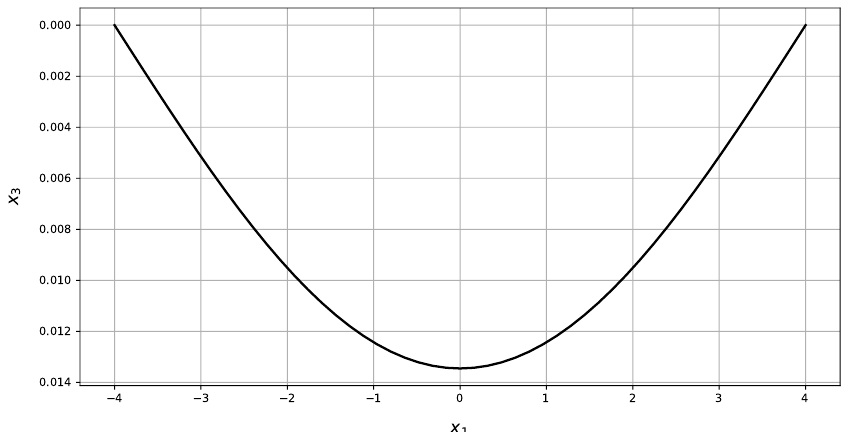
Figure 8. The deflection in section x 2 = 2 of a rectangular plate with two opposite edges simply supported and the other